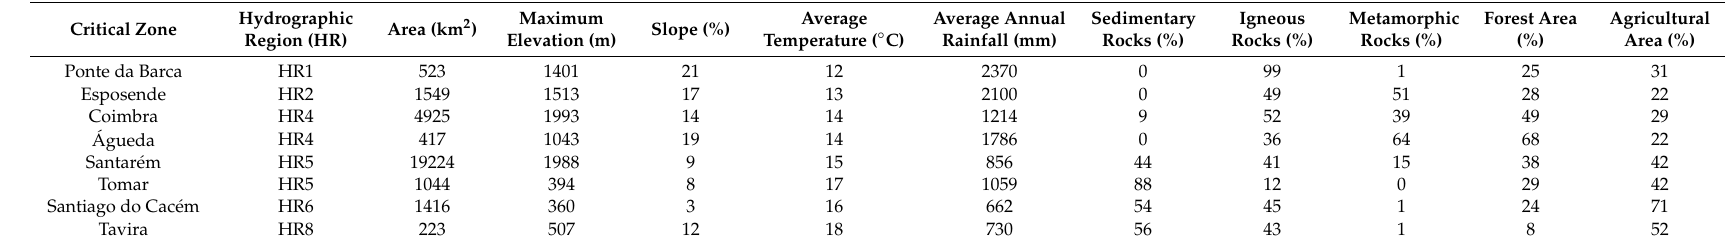
Table 2. Characterization of the eight Critical